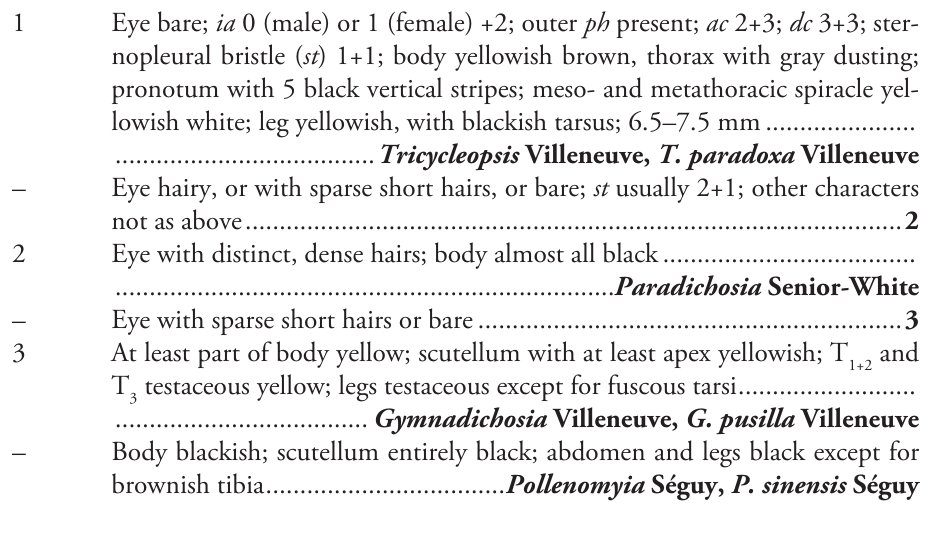
Subfamily MELANOMYINAE